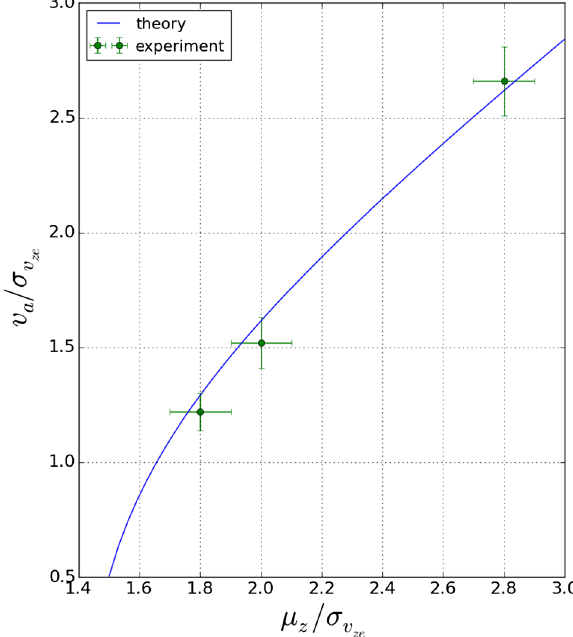
FIG. 9. Theoretical and experimentally measured radius of a circular attractor in the ions ’ longitudinal phase space created by a constant offset of the electron beam energy.